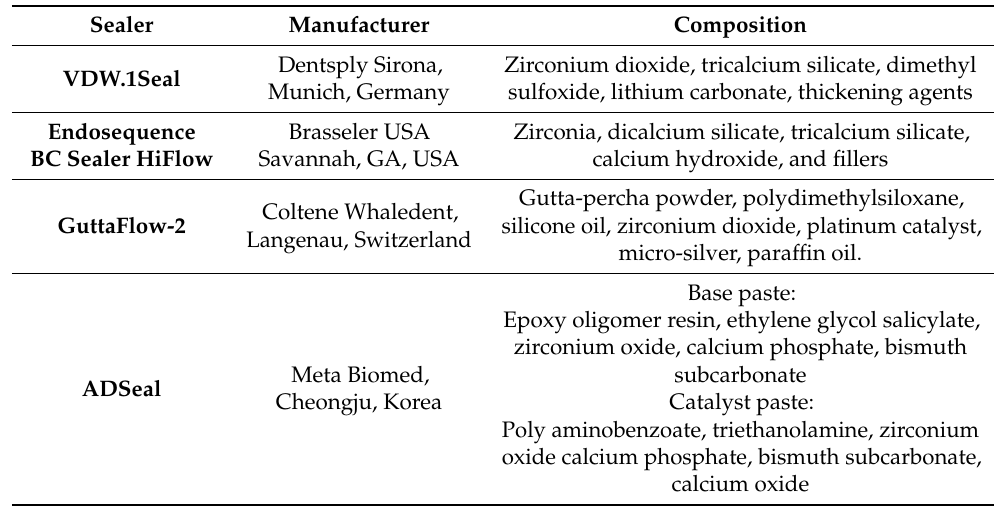
Table 1. Composition of sealers used in this